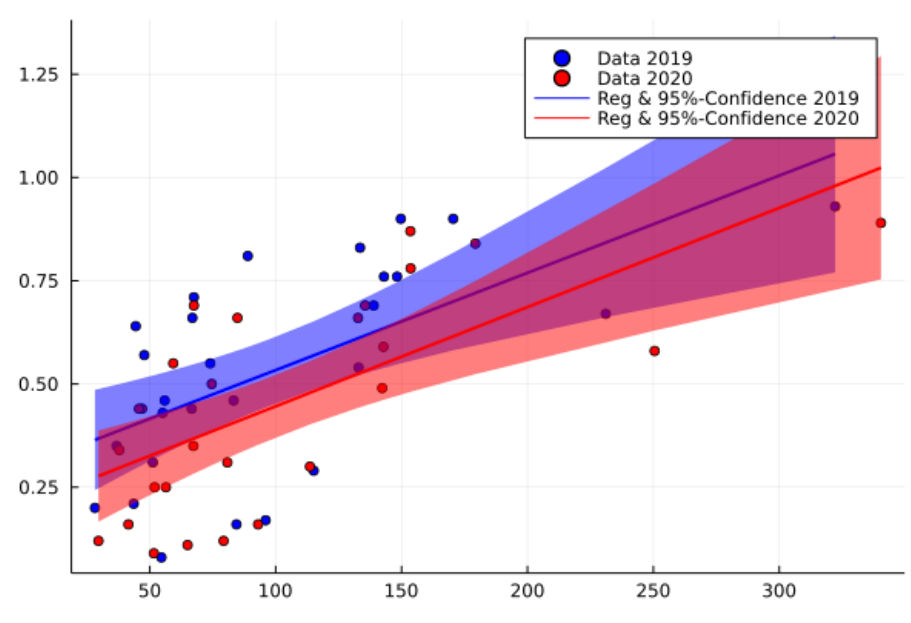
Figure 2. Regression Outcome. Source: author. Table 3. Regression Table of Difference-In-Difference Regression and Fixed-Effect Panel